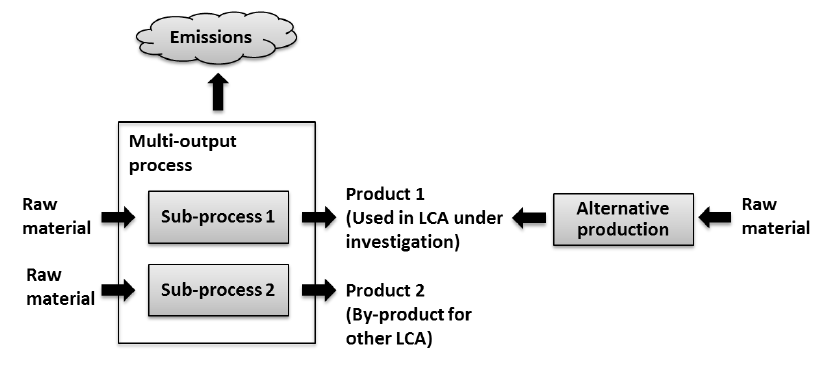
Figure 1. Overview of the allocation problem in multi-output